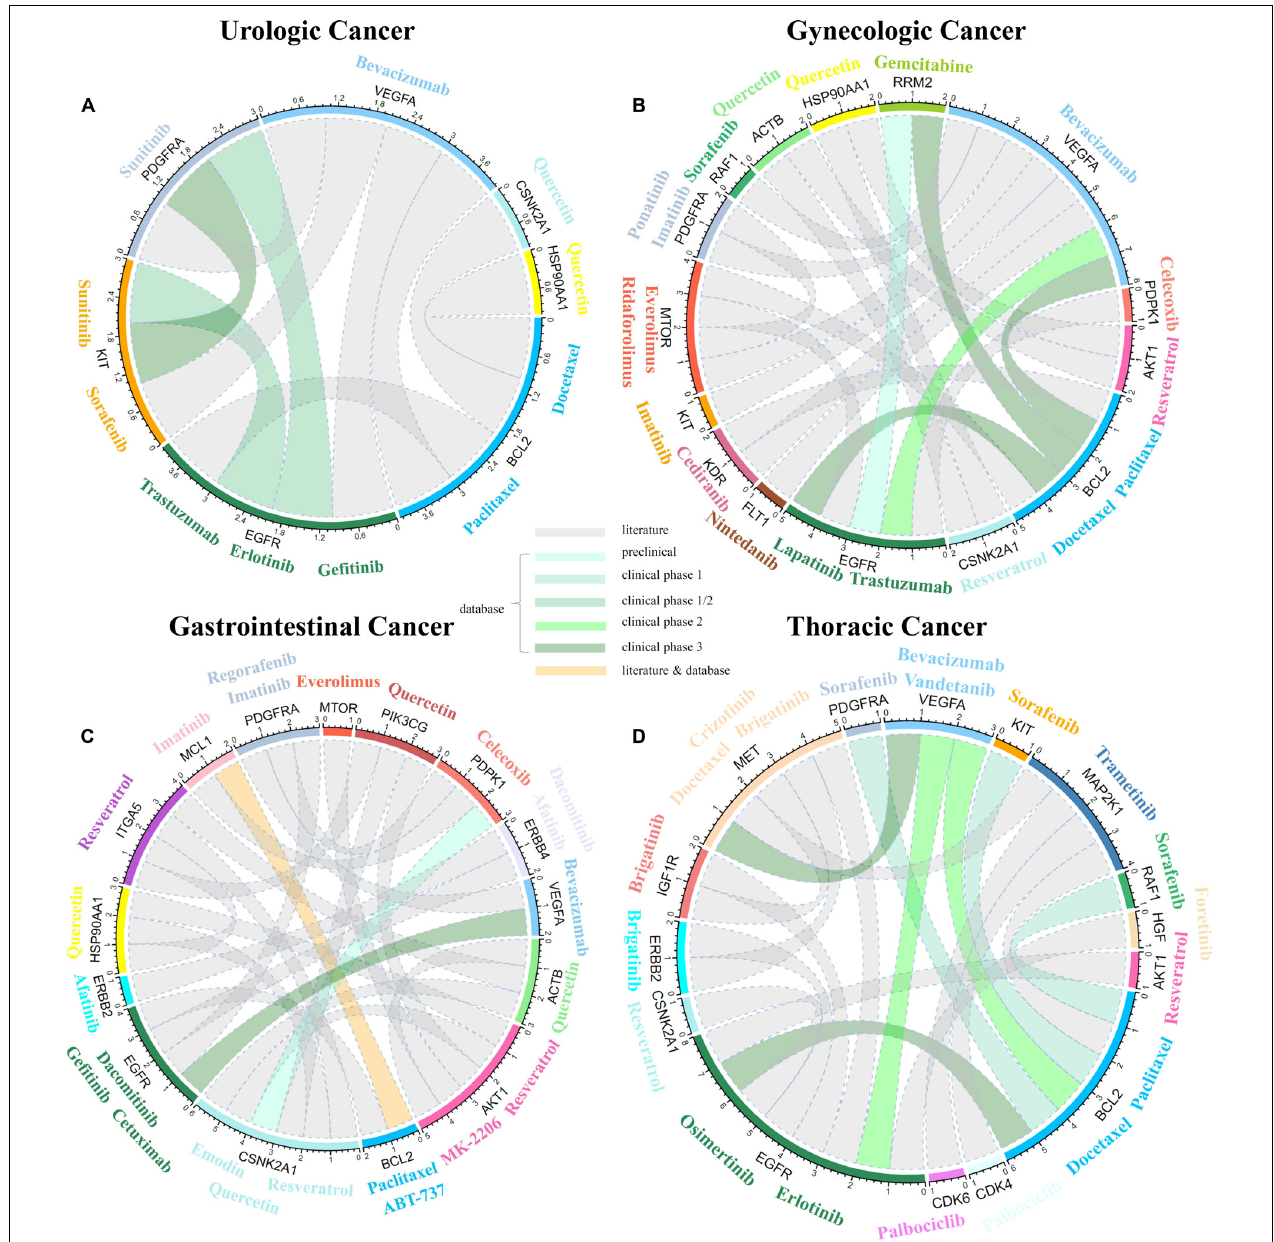
FIGURE 7 | Previously detected drug combinations and corresponding drug targets. The color for each line which linked two genes represents different levels of evidence including literature, database (preclinical, clinical phase 1, clinical phase 1/2, clinical phase 2, clinical phase 3), literature and database. (A) Drug combinations and corresponding drug targets for urologic cancer. (B) Drug combinations and corresponding drug targets for gynecologic cancer. (C) Drug combination and corresponding drug targets for Gastrointestinal (GI) cancer. (D) Drug combination and corresponding drug targets for thoracic